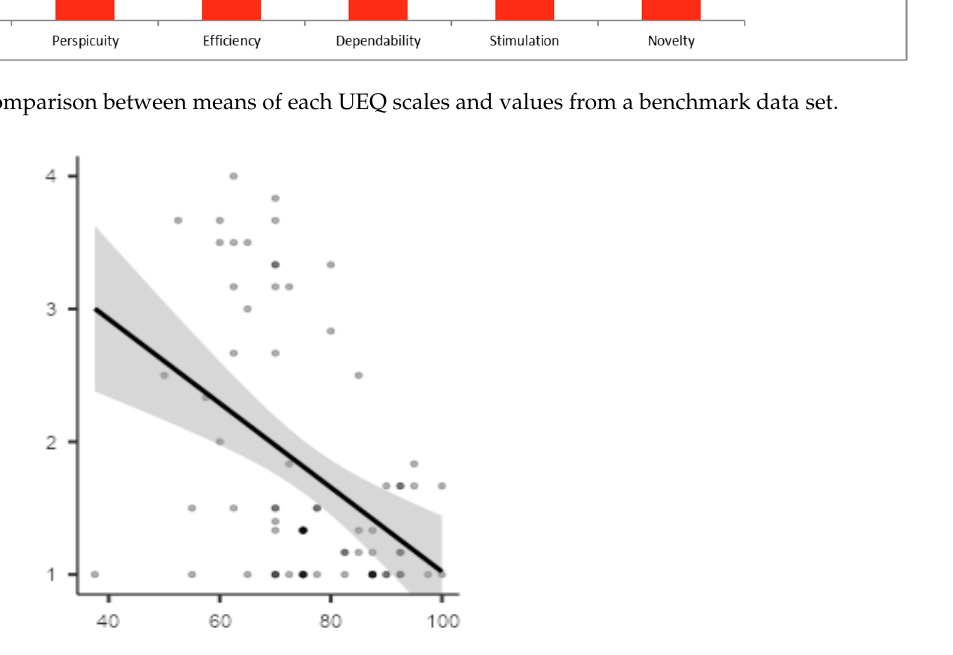
Figure 8. Graphic representation of negative correlation between negative effects and SUS total score.